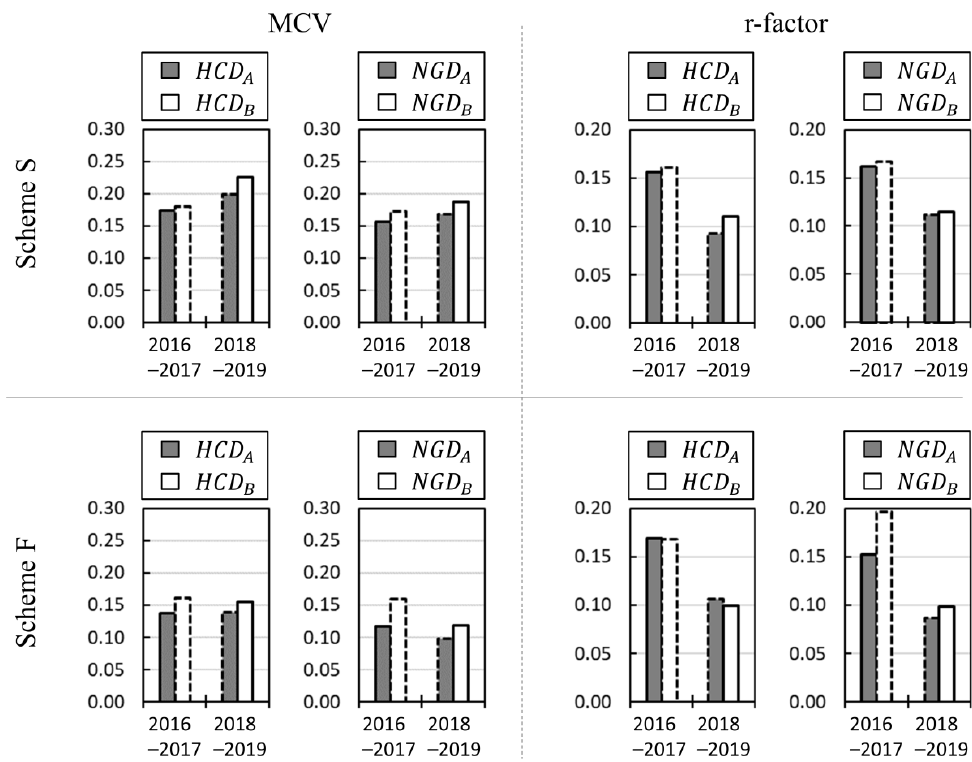
Figure 7. MCV and r-factor between observed daily stream flow and simulated daily stream flow by calibration schemes S and F for 2016–2017 and 2018–2019. The solid line bars indicate results for calibration periods, and the dotted line bars indicate ones for validation